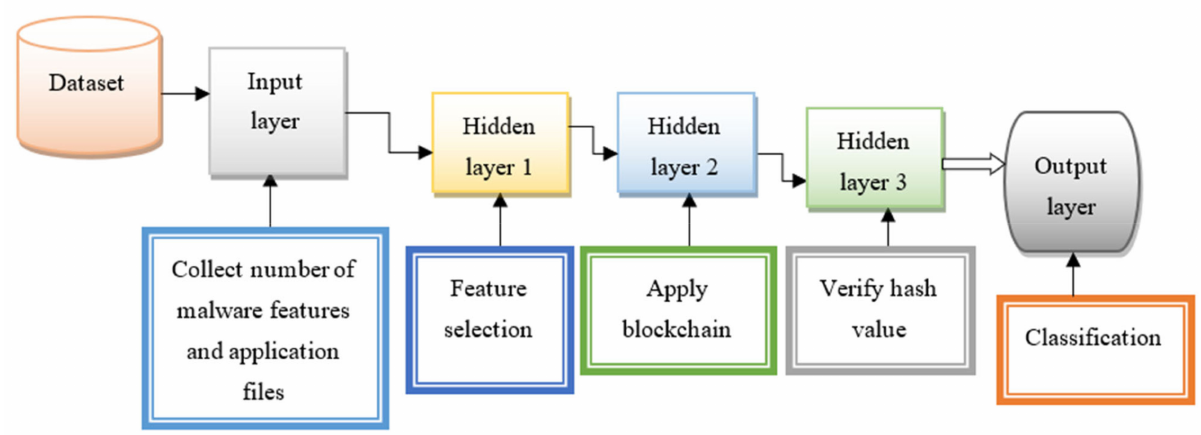
Figure 3. Structure of deep multilayer perceptive learning with one input layer, three hidden layer, one output